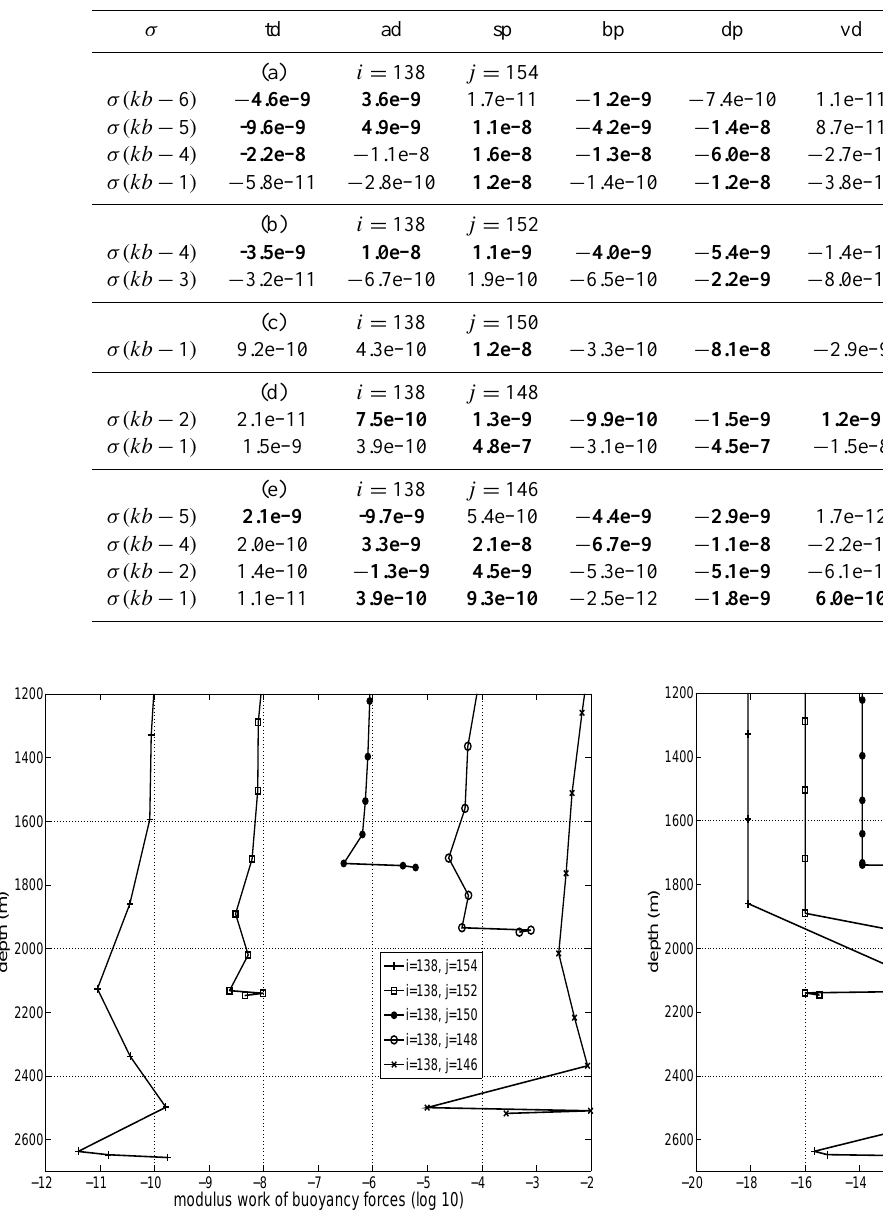
Fig. 11. Profiles of bp, i.e. modulus of work of buoyancy forces or Fig.11. Profilesof bp, i.e.,modulus ofwork ofbuoyancy forces ormodulus of buoyancy production [ m 2 /s 3 ] . modulus of buoyancy production (m 2 s − 3 ). Note, that values of bp Note, thatvalues ofbparealways negative. Profilesareoffset asinFig.8. are always negative. Profiles are offset as in Fig. 8.